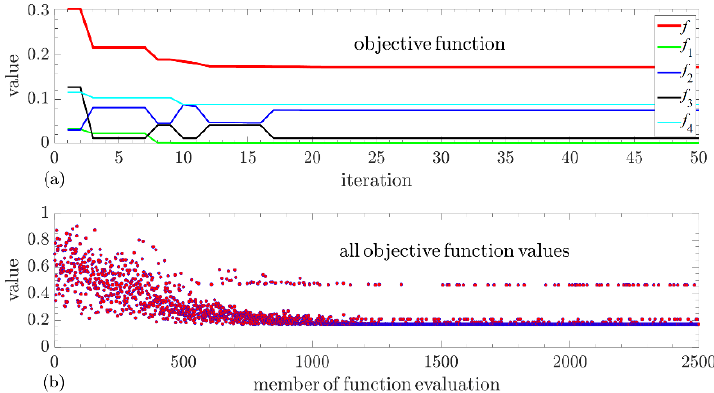
Figure 8. The results of all objective functions and all objective functions values for small substation: